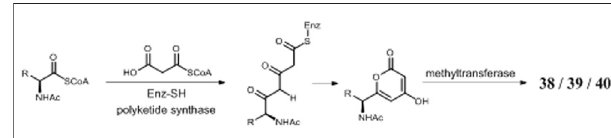
FIGURE 4 | Proposed biosynthetic pathway of campyrones.